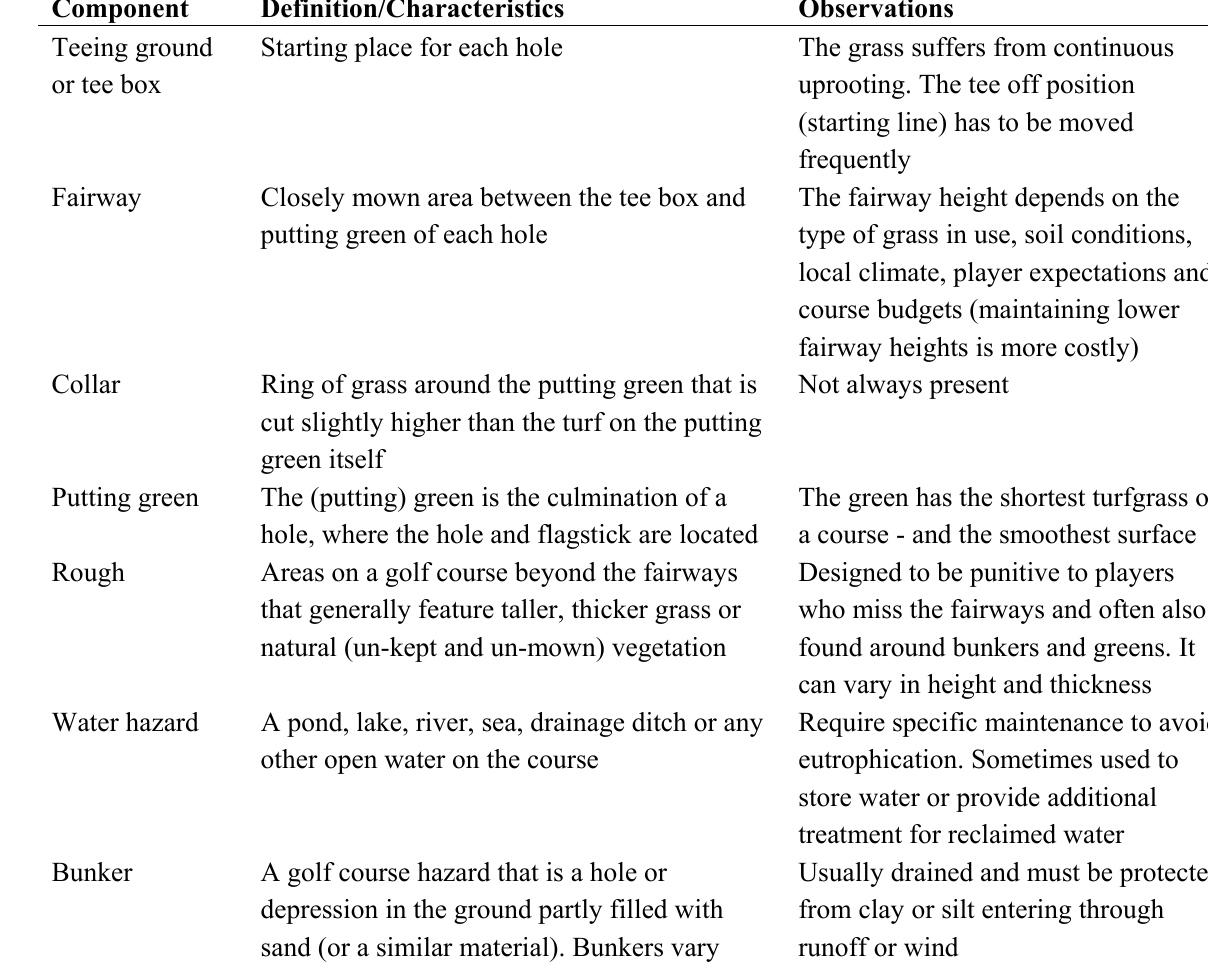
Table 1. Sport related components of a golf course (modified from